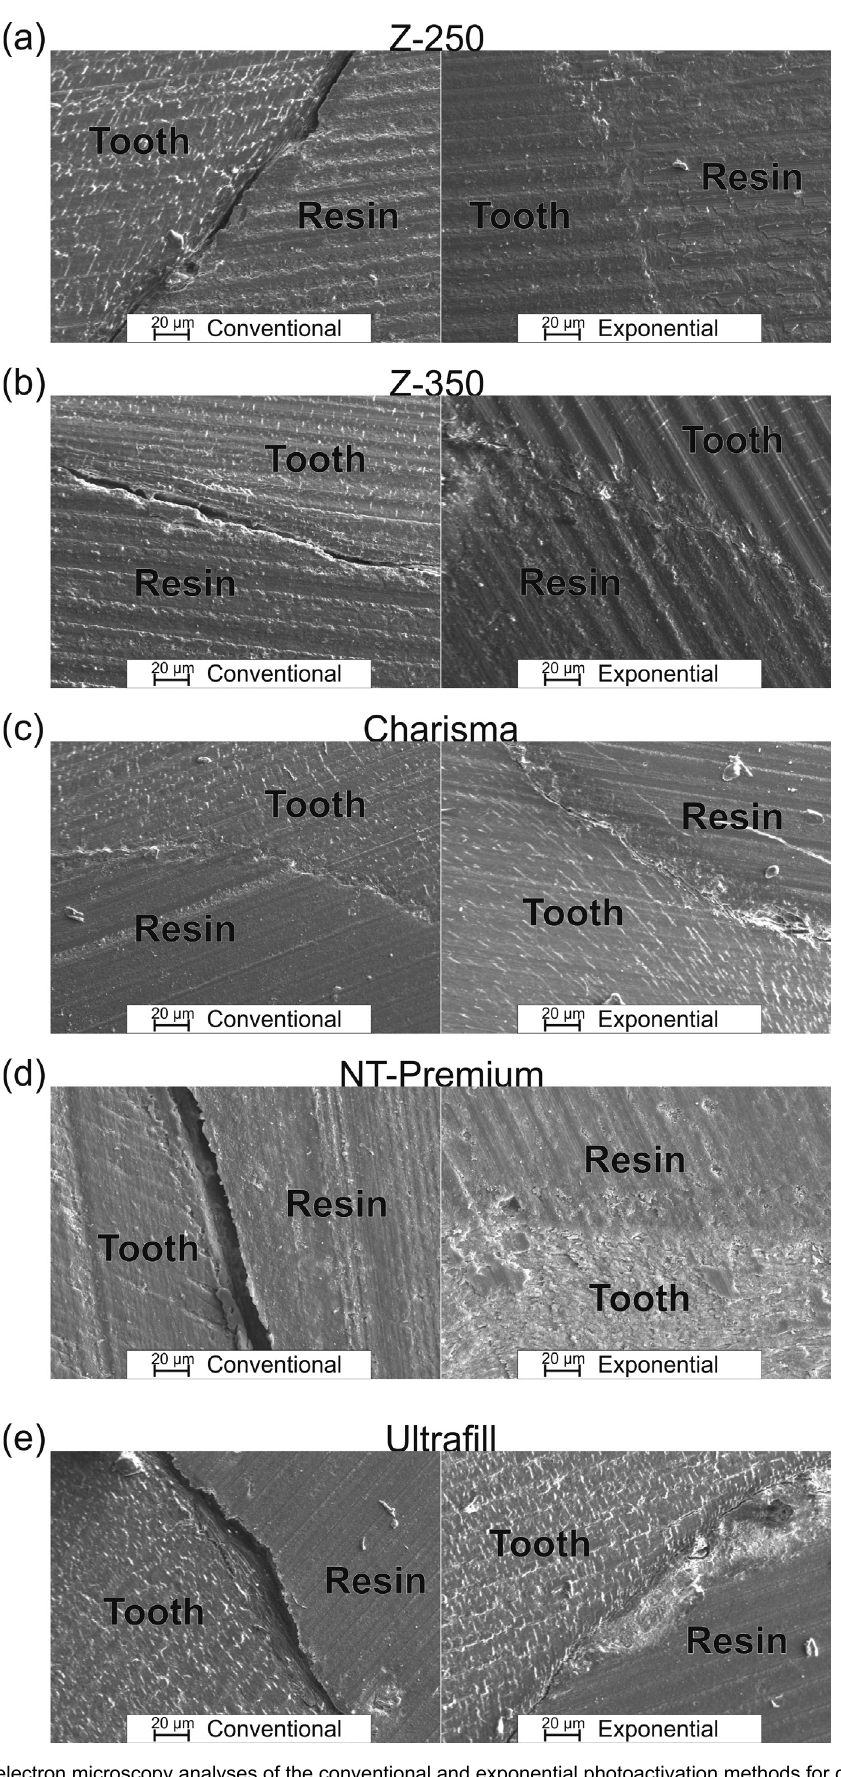
Figure 3- Scanning electron microscopy analyses of the conventional and exponential photoactivation methods for composite resins: (a) Z-250; (b) Z-350; (c) Charisma; (d) NT Premium and (e)